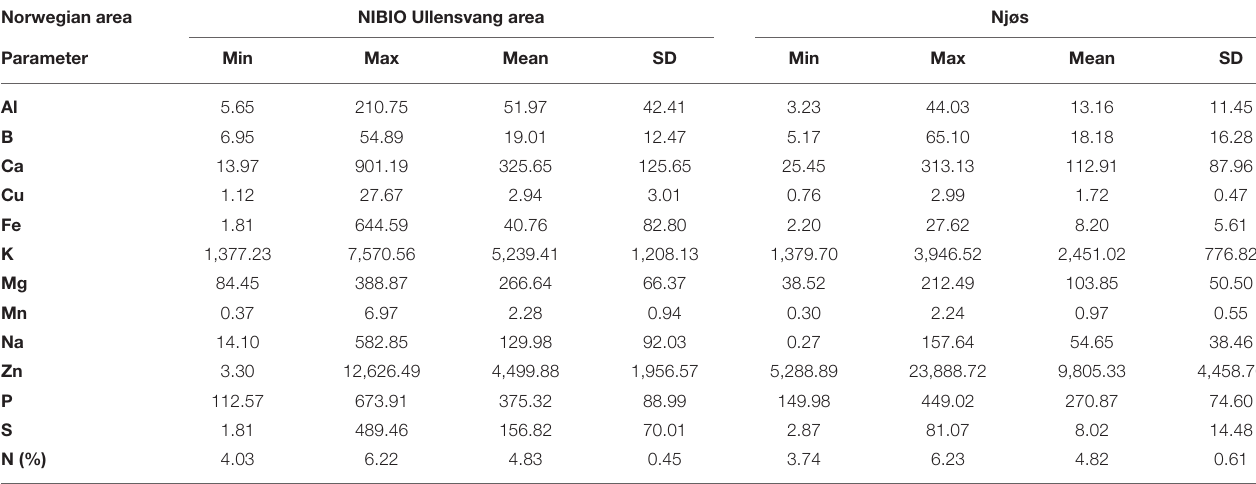
TABLE 3 | Descriptive analysis of content of nutrients (mg/kg dw) in Norwegian apple samples from the NIBIO Ullensvang area (no. 1–74) and from Njøs (no. 75–103) during 2-year harvesting. Norwegian area NIBIO Ullensvang area